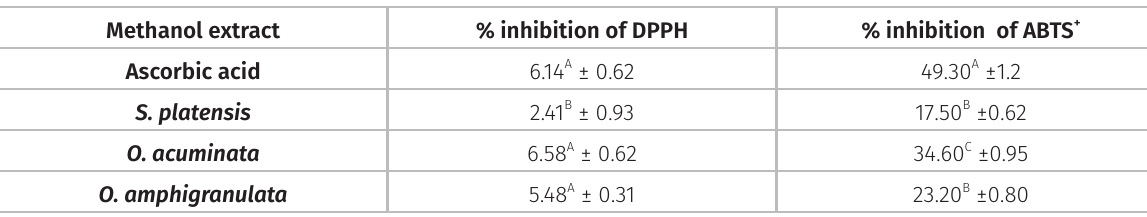
Table IV. The antioxidant activity of cyanobacterial species methanolic extracts.